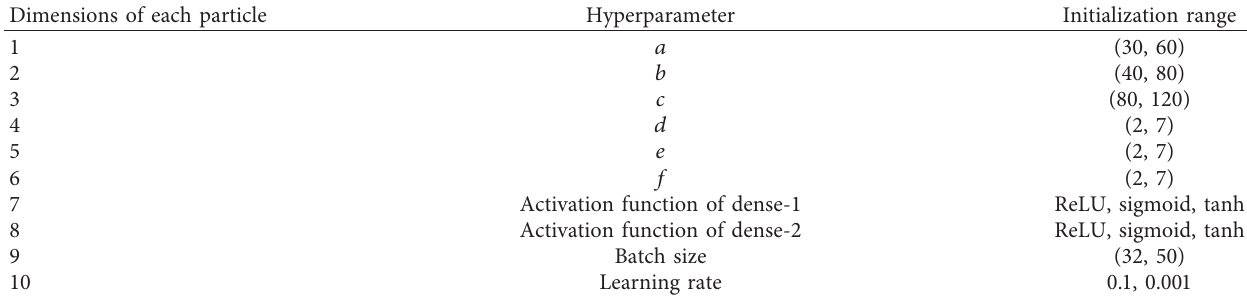
Table 2: Hyperparameters setting to be